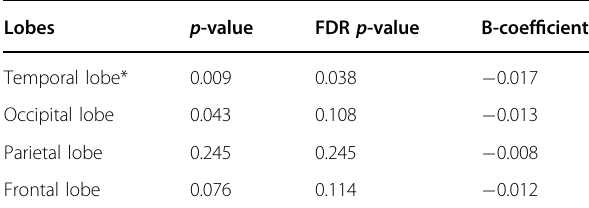
Table 3 The associations between “ voices ” ( N = 254) and lobar